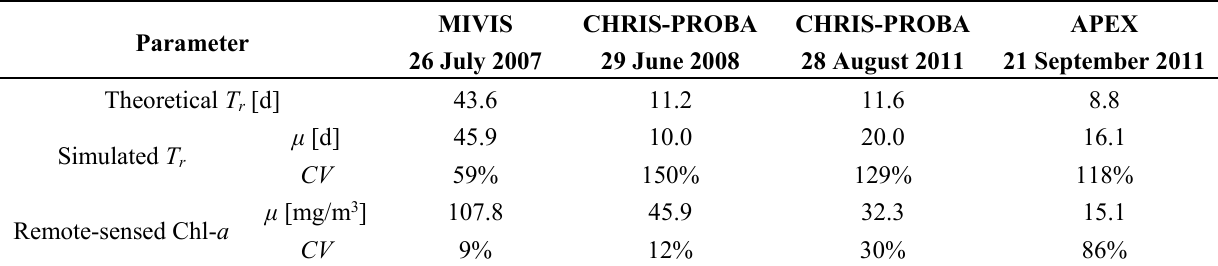
Table 4. Theoretical T r estimates and μ and CV values of simulated T r and remote-sensed Chl- a concentration for the simulated images